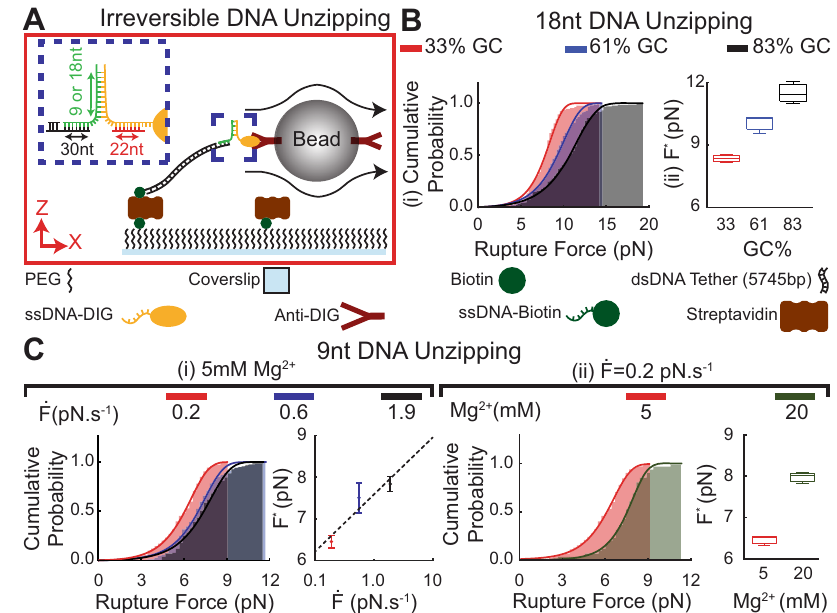
Fig. 3 | Assessment of double stranded DNA unzipping using hydrodynamic force spectroscopy. A Schematic of the setup used for mechanical unzipping of dsDNA.TheDNAtetherfeaturesaBiotinendthatenablesanchoringofthetetherto the coverslip surface and a single-stranded end that binds to a short oligo (green oligo). A fraction of the green oligo enables binding to the tether, and another fraction enables binding to another short oligo conjugated to DIG (orange oligo). Similarly, a fraction of the orange oligo enables binding to the green oligo, and another fraction enables binding to a third short oligo (red oligo). B Cumulative probability histogram of DNA unzipping force for 18nt dsDNA with 33%, 58%, and 83% GC content. Increase in GC content caused the rupture events to occur at higher forces. N =3 most probable rupture forces (F * ) were estimated based on random selection without replication of the recorded rupture force data for each GC content. The estimated F * values are presented as median (center), 25 – 75